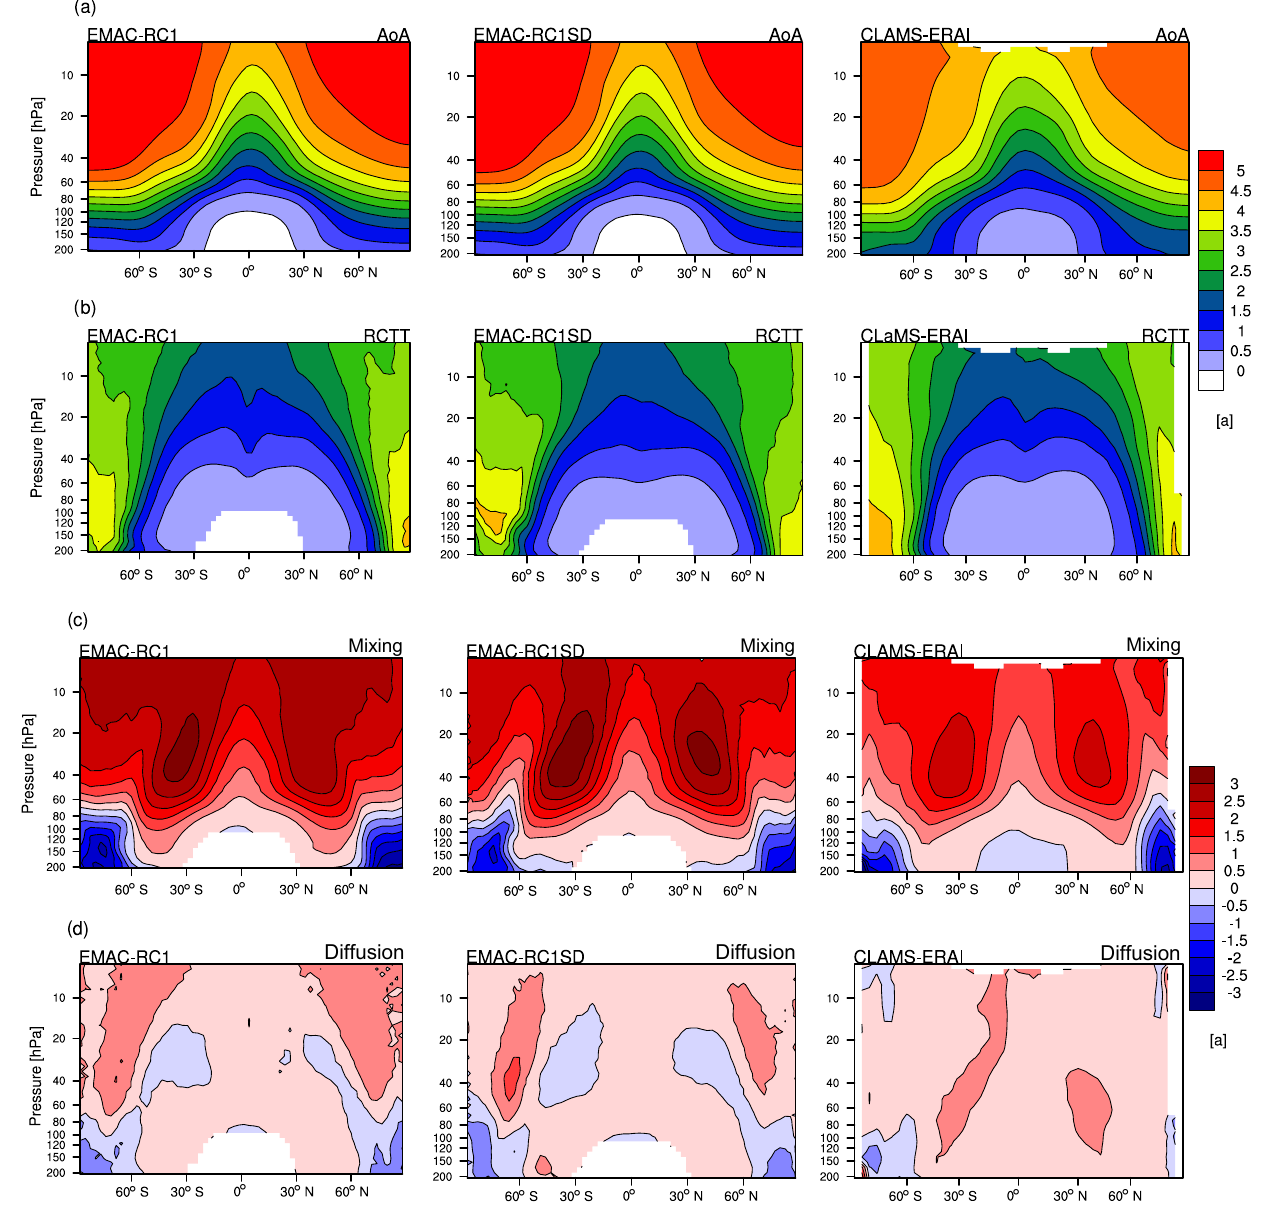
Figure 1. Zonal annual mean of (a) AoA, (b) RCTT, (c) resolved aging by mixing and (d) aging by diffusion from the years 1990 to 2011 for the simulations EMAC-RC1 (left), EMAC-RC1SD (middle) and CLaMS-ERAI (right). Units are given in years [a].